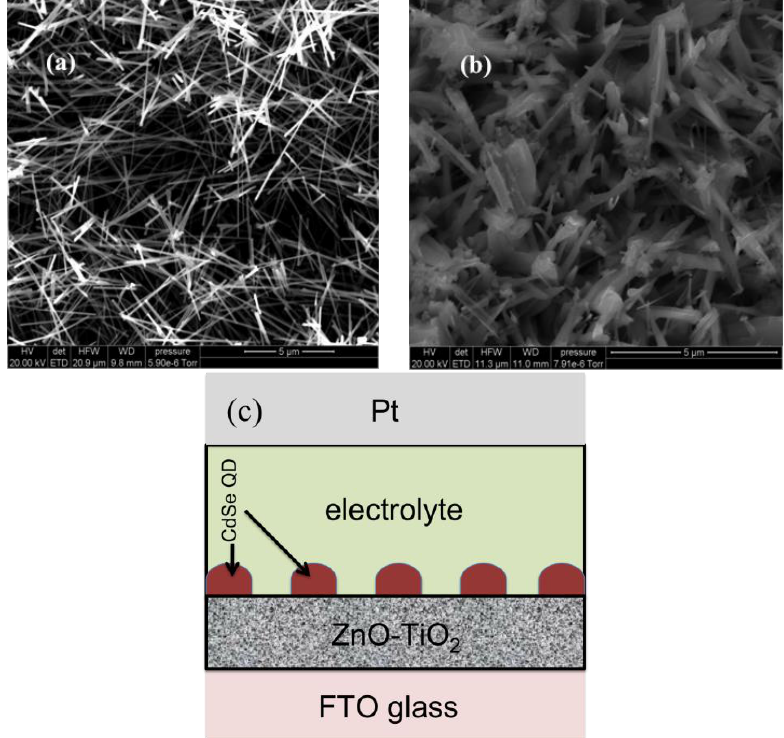
Figure 1. ( a ) Scanning electron microscopy (SEM) image of the as-grown ZnO nanowires. ( b ) Hybrid film after sintering with TiO 2 . ( c ) Schematic of cell structure.